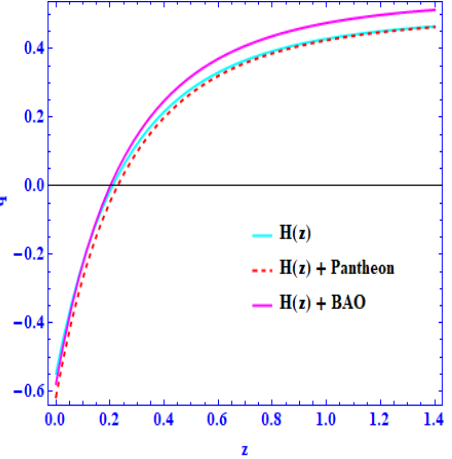
Figure 8. Variation of deceleration parameter versus redshift z for H ( z ) data (left panel, H ( z ) + Pantheon compilation of SN Ia data (middle panel) and H ( z ) + BAO data (right panel).